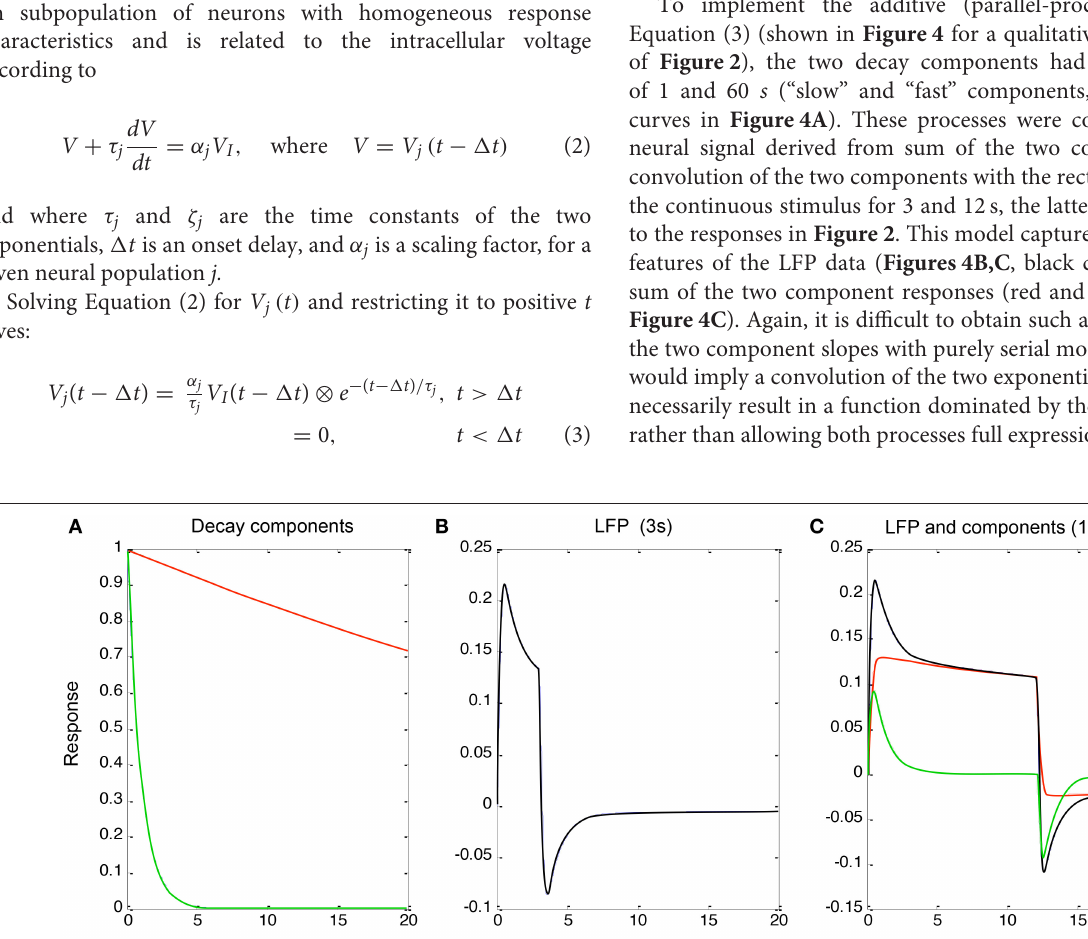
Frontiers in Neuroscience |